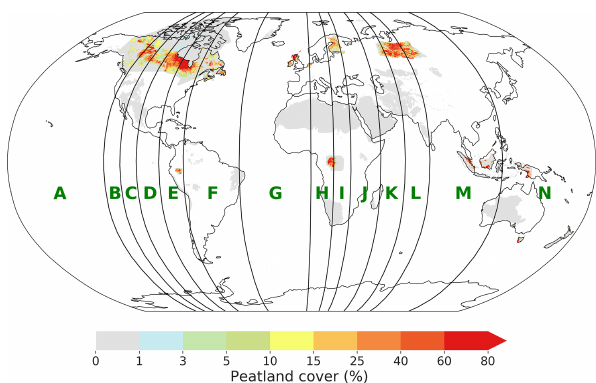
Figure 2. Training data for the LightGBM algorithm. Areas in white have no data. The green letters denote the blocks used for the cross- validation scheme. The training block limits were chosen as de- scribed in Sect.